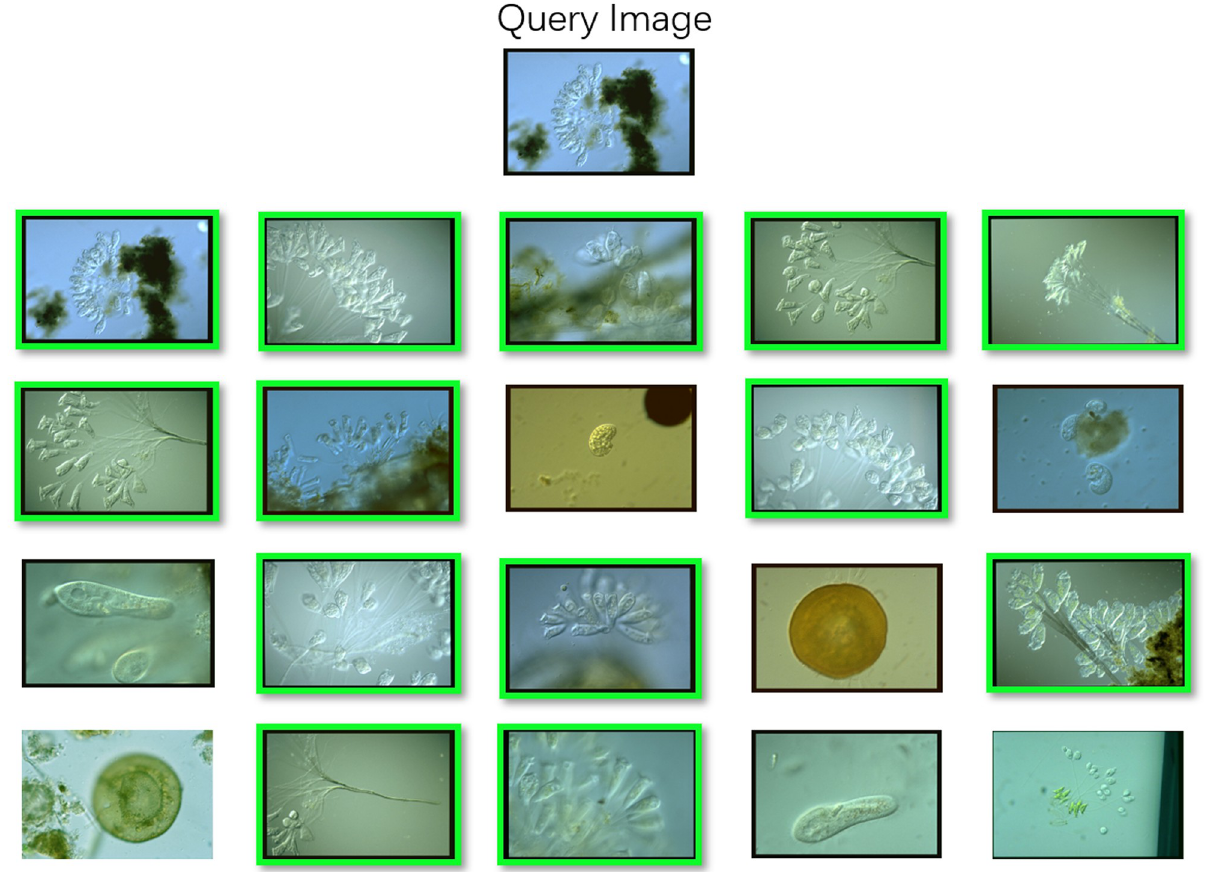
Fig 9. An example of image retrieval results with GLCM using